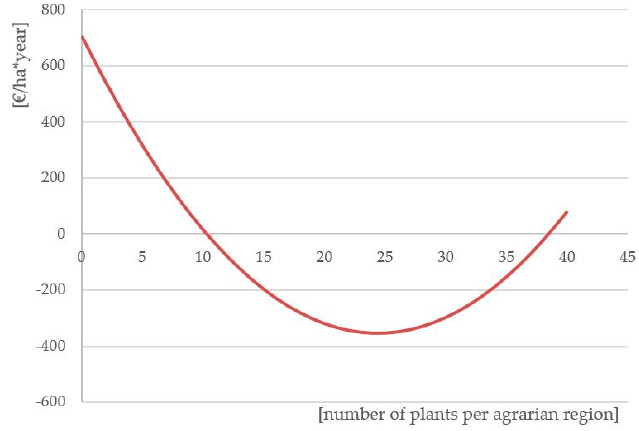
Figure 5. Function of the average plants’ power in the agrarian region on rental price ( pp_r ).